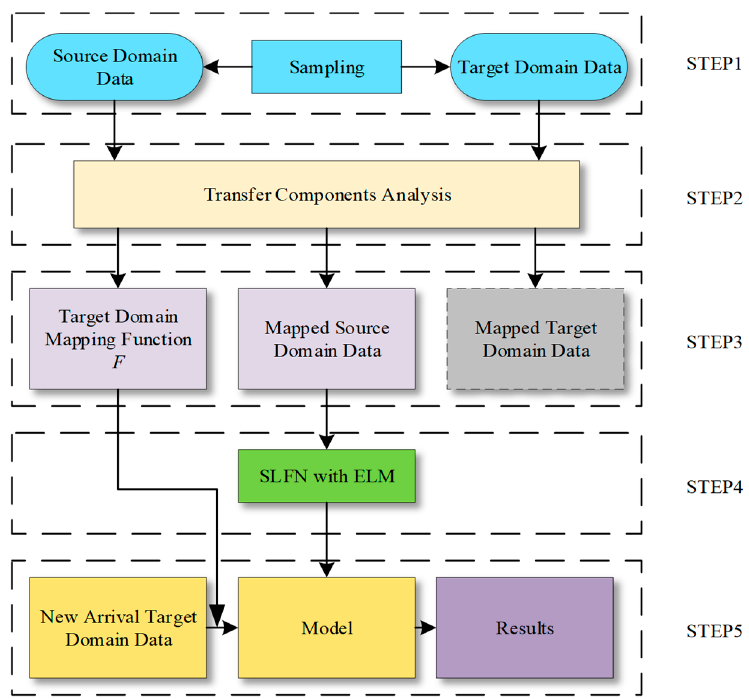
Figure 6. Framework for lithium battery prediction . SLFN—single hidden layer feed forward neural network .